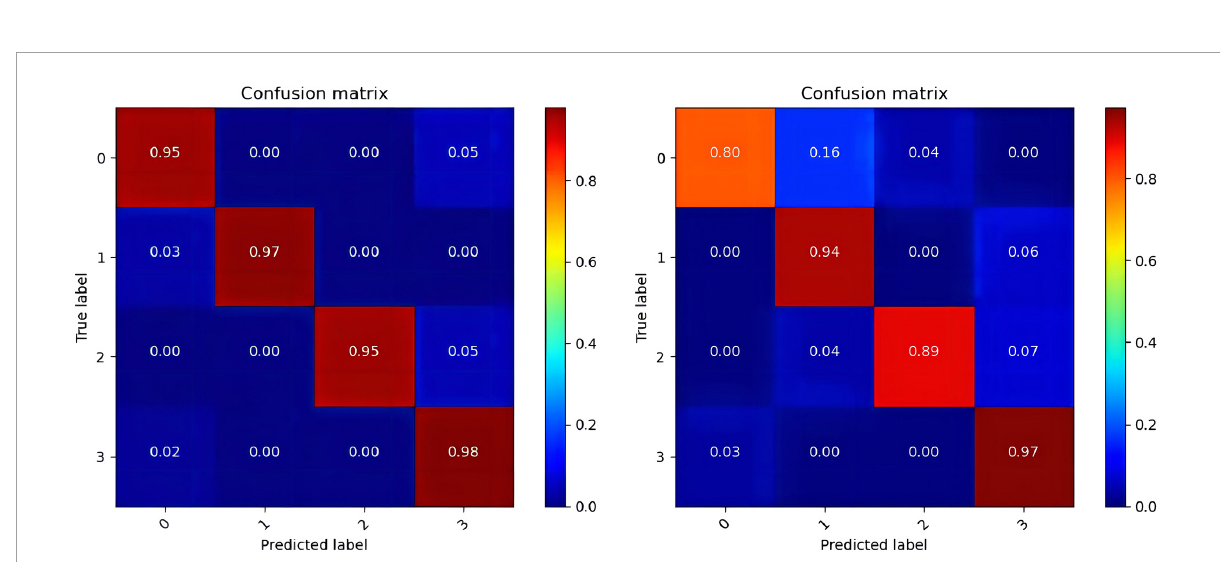
FIGURE7 The confusion matrixes of datasets. (The confusion matrix of the DEAP in the left, the confusion matrix of the SEED-IV in the